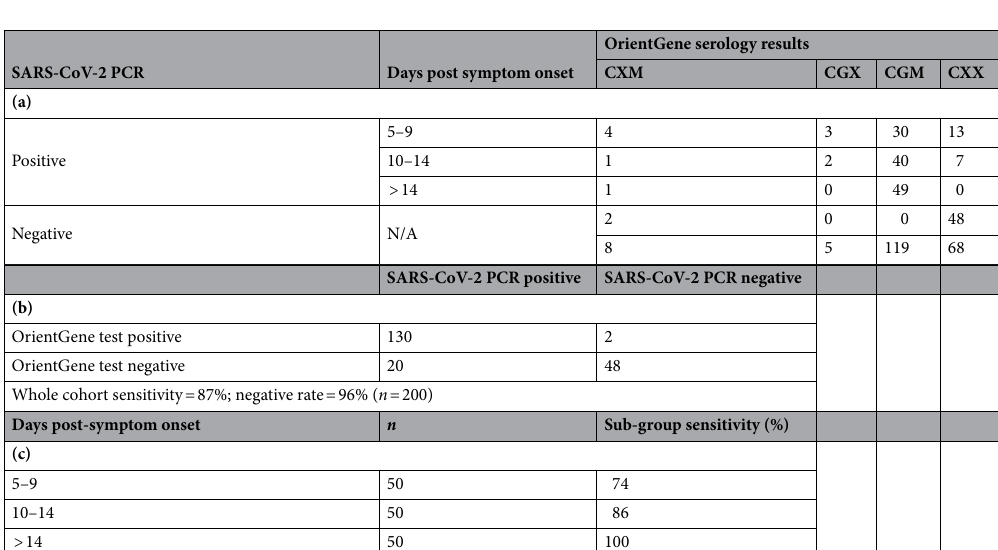
Figure 2. Flowchart demonstrating patient recruitment and subsequent SARS-CoV-2 PCR and serological status. All recruited individuals were inpatients at the time of testing. All patients had a screening chest x-ray as part of the admission protocol and specific comments on findings, or absence of, associated with SARS-CoV-2 infection. None of the 50 negative arm patients had radiological findings consistent with probably SARS-CoV-2 infection. All patients in the positive arm were considered to have moderate to severe SARS-CoV-2 infection, and had radiological findings that were in keeping with probable SARS-CoV-2 infection.